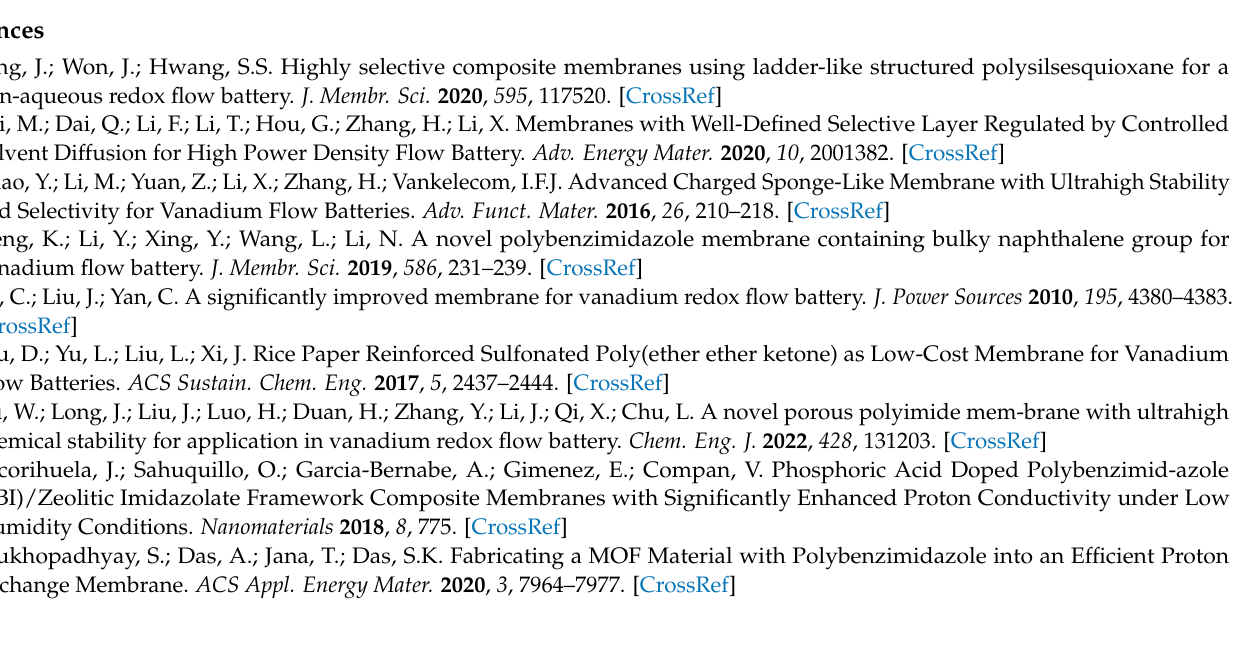
Figure S3: The oxidative stability of the AmPBI-MOE-PIL-5 membranes. Figure S4: Thermal stability of composite